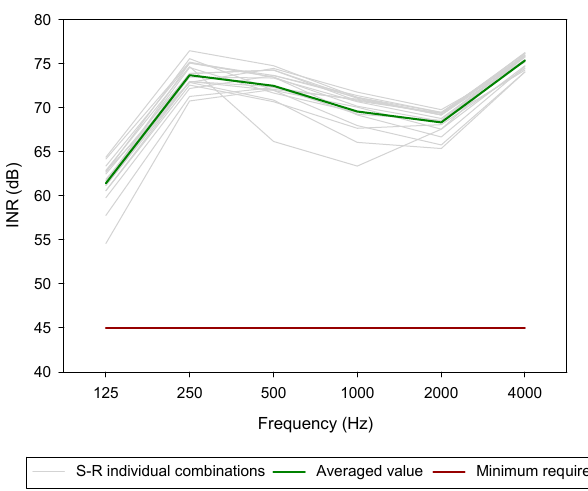
Figure 4. Impulse-to-noise ratio (INR) measured values obtained at each source-receiver combination characterised in the York Minster’s Chapter House (grey lines) and the spatially averaged values (green line). The minimum value of INR required for a reliable calculation of T 30 is also shown (red line).